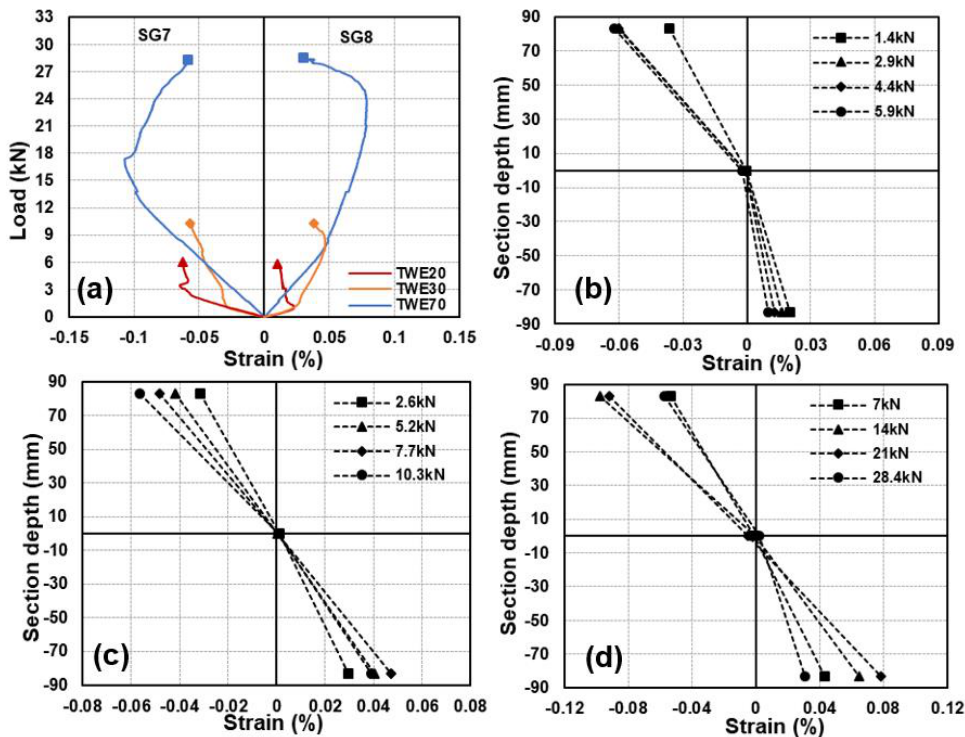
Figure 11. Strain responses at section A. ( a ) Load–strain responses for TWE specimens; ( b ) strain distribution along depth for TWE20; ( c ) strain distribution along depth for TWE30; and ( d ) strain distribution along depth for TWE70.